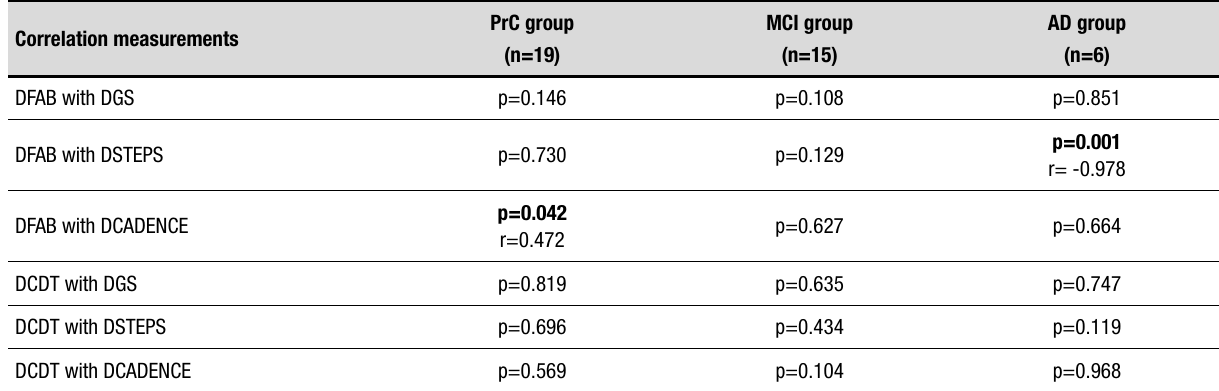
Table 3. Correlation between change in Frontal Assessment Battery and clock-drawing test tests and change in gait speed among older adults with preserved cognition, mild cognitive impairment, and mild Alzheimer disease. Correlation